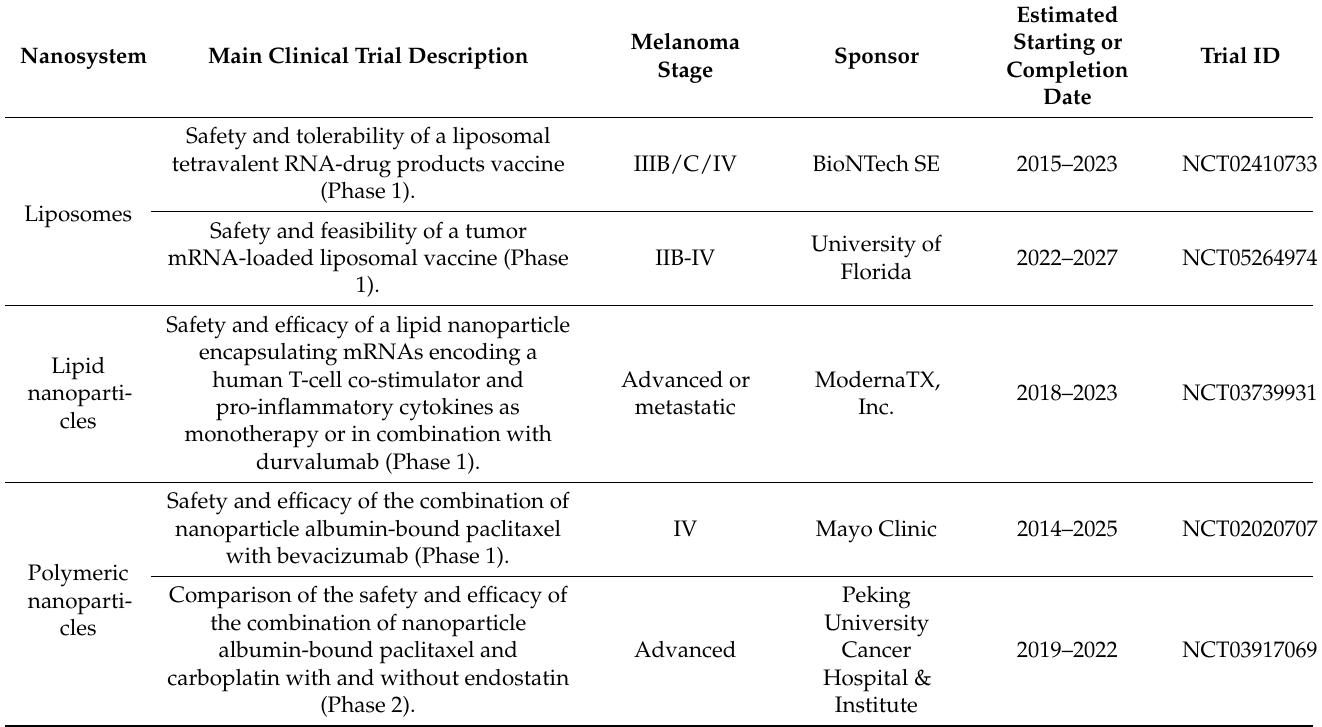
Table 6. Examples of ongoing or programmed clinical trials using different types of nanosystems for melanoma